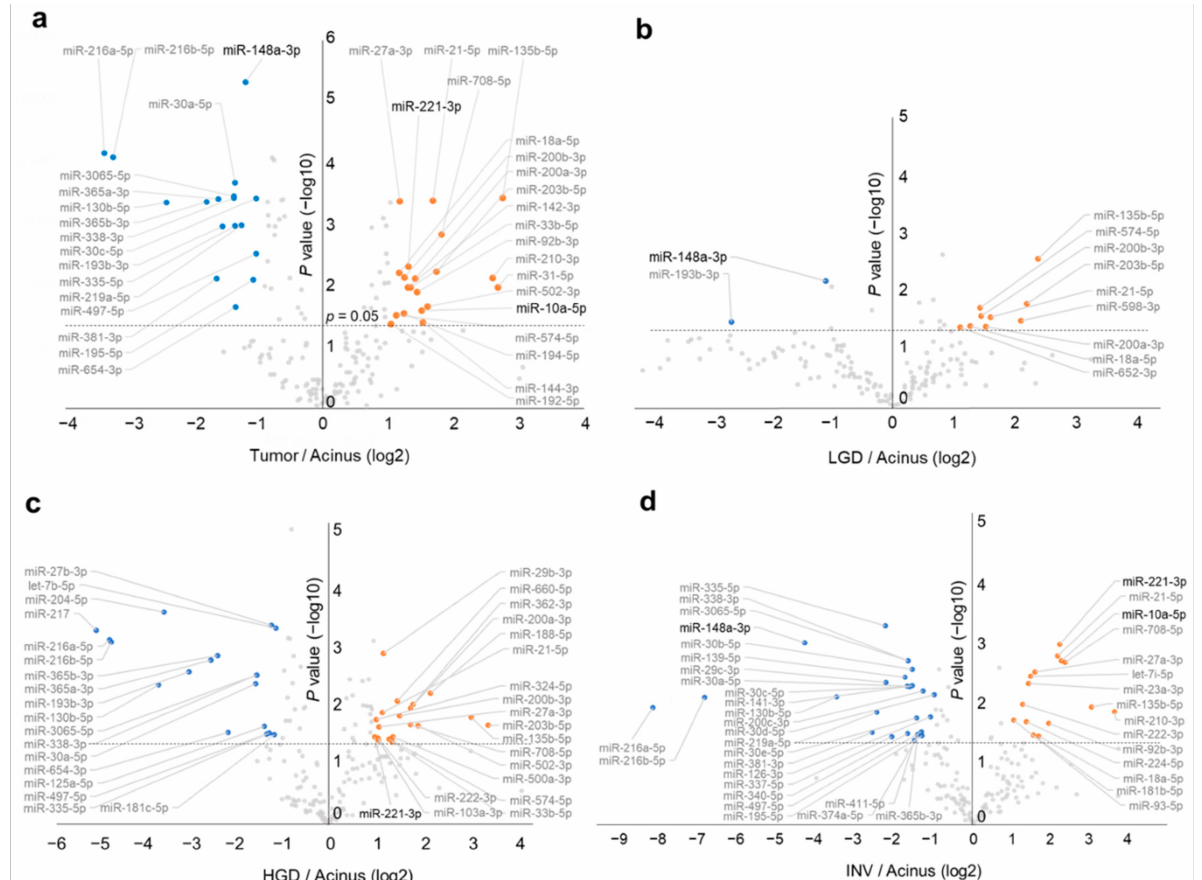
Figure 1. Volcano plots of next-generation sequencing data show differential miRNA expressions in intraductal papillary mucinous neoplasm (IPMN) between tumor tissue and its paired normal acinus tissue. ( a ) All IPMN cases ( n = 19). ( b ) Cases with low-grade dysplasia (LGD) ( n = 4). ( c ) Cases with high-grade dysplasia (HGD) ( n = 9). ( d ) Cases with invasive carcinoma (INV) ( n = 6). Orange dots show significantly upregulated miRNAs (fold-change > 2, p < 0.05), and blue dots show significantly downregulated miRNAs (fold-change < 0.5, p <